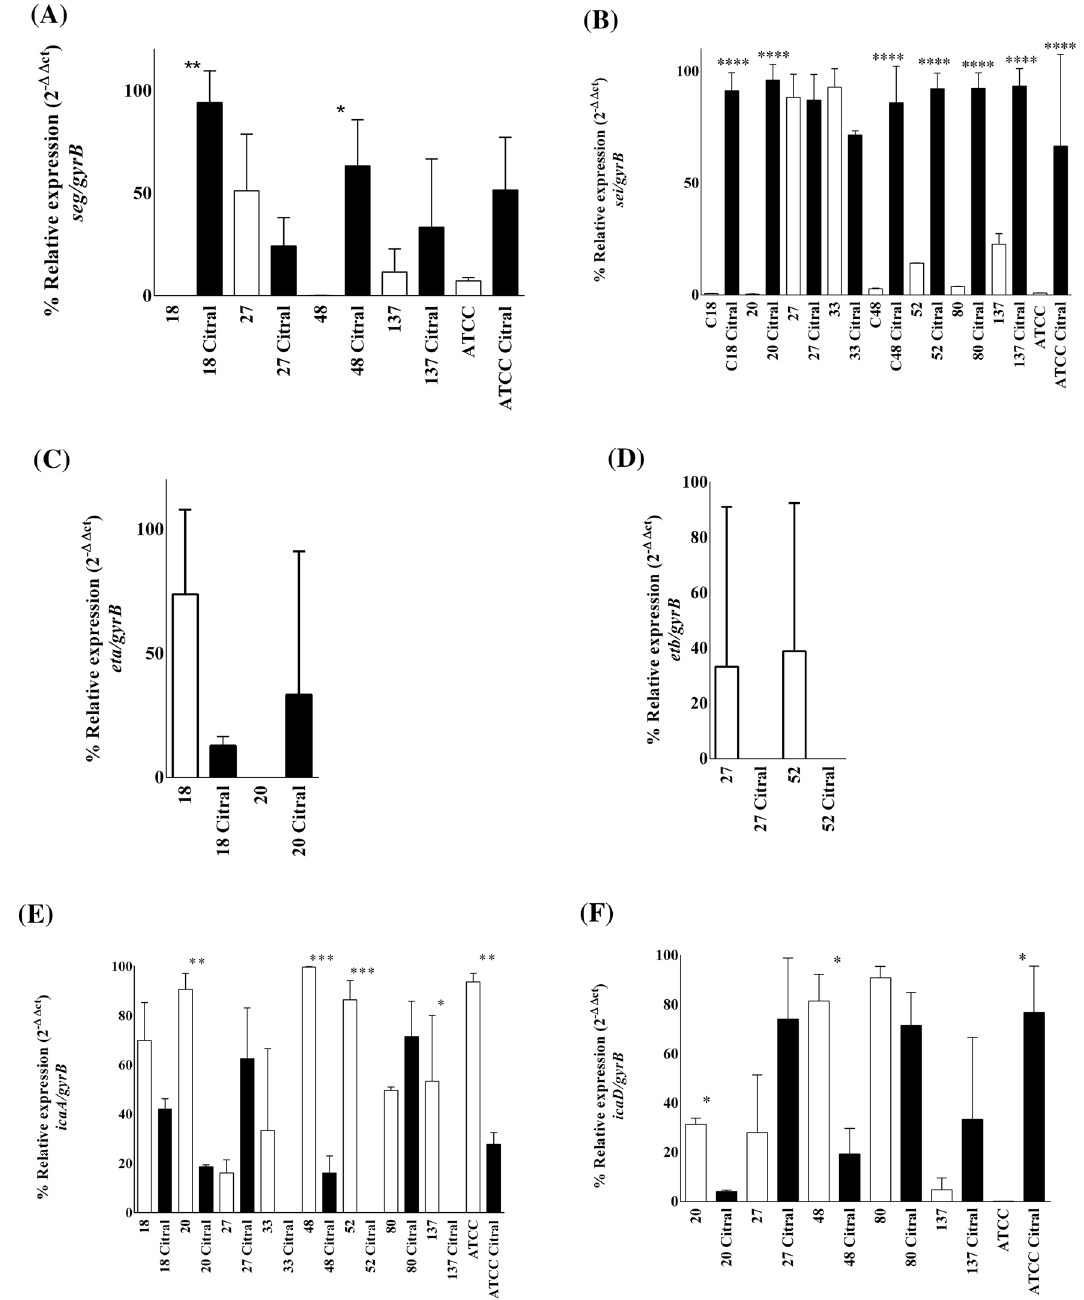
Figure 4. Relative expression of virulence genes seg (A) , sei (B) , eta (C) , etb (D) , icaA (E) and icaD (F) of the MRSA strains (18, 20, 27, 33, 48, 52, 80, 137) and ATCC 33591 control and with 25 mg/mL (2.5%) citral treatment. Significant difference considering P -value ≤ 0.05 (*), P -value ≤ 0.01 (**), P -value ≤ 0.001 (***), using Mann–Whitney one-tailed test and Kruskal–Wallis test with Dunn’s